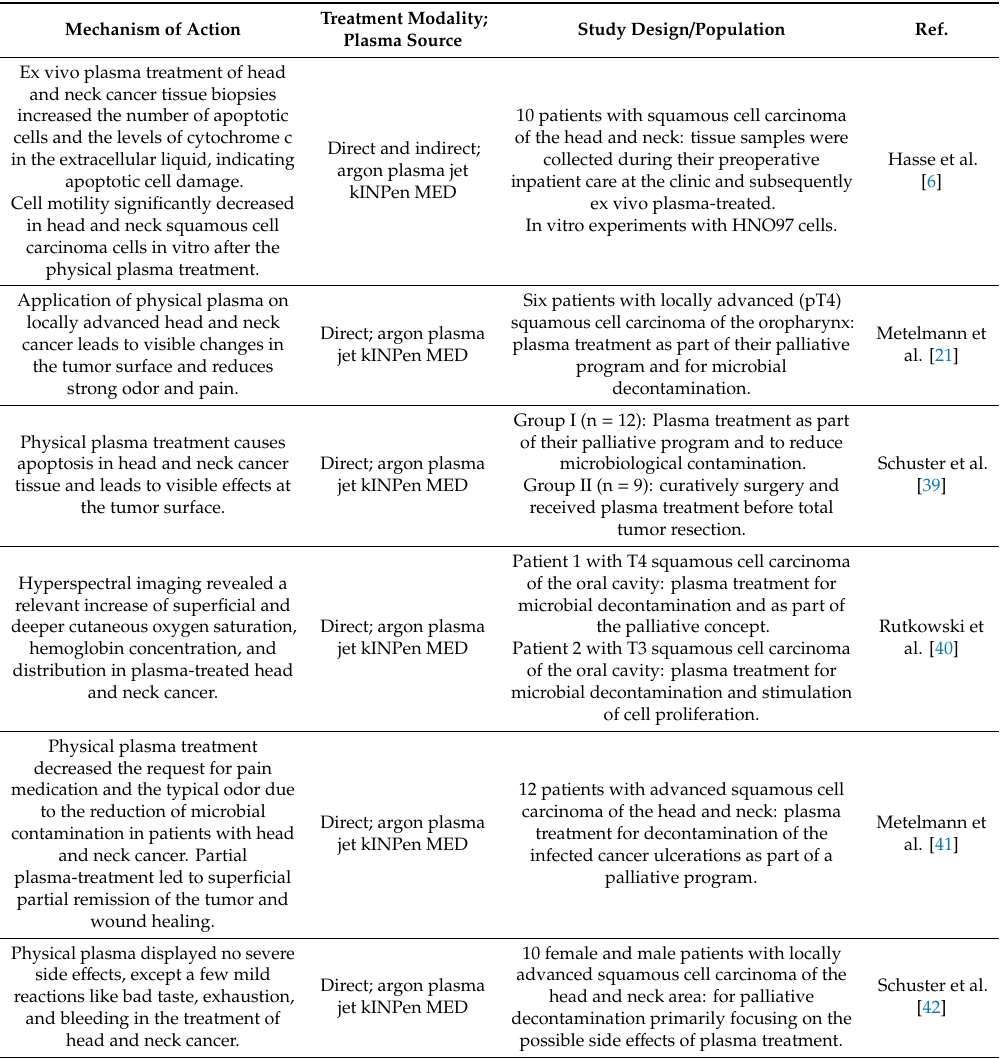
Table 2. Impact of physical plasma treatment on squamous cell carcinoma of the head and neck region in patients in vivo and of tumor tissue treated with plasma ex